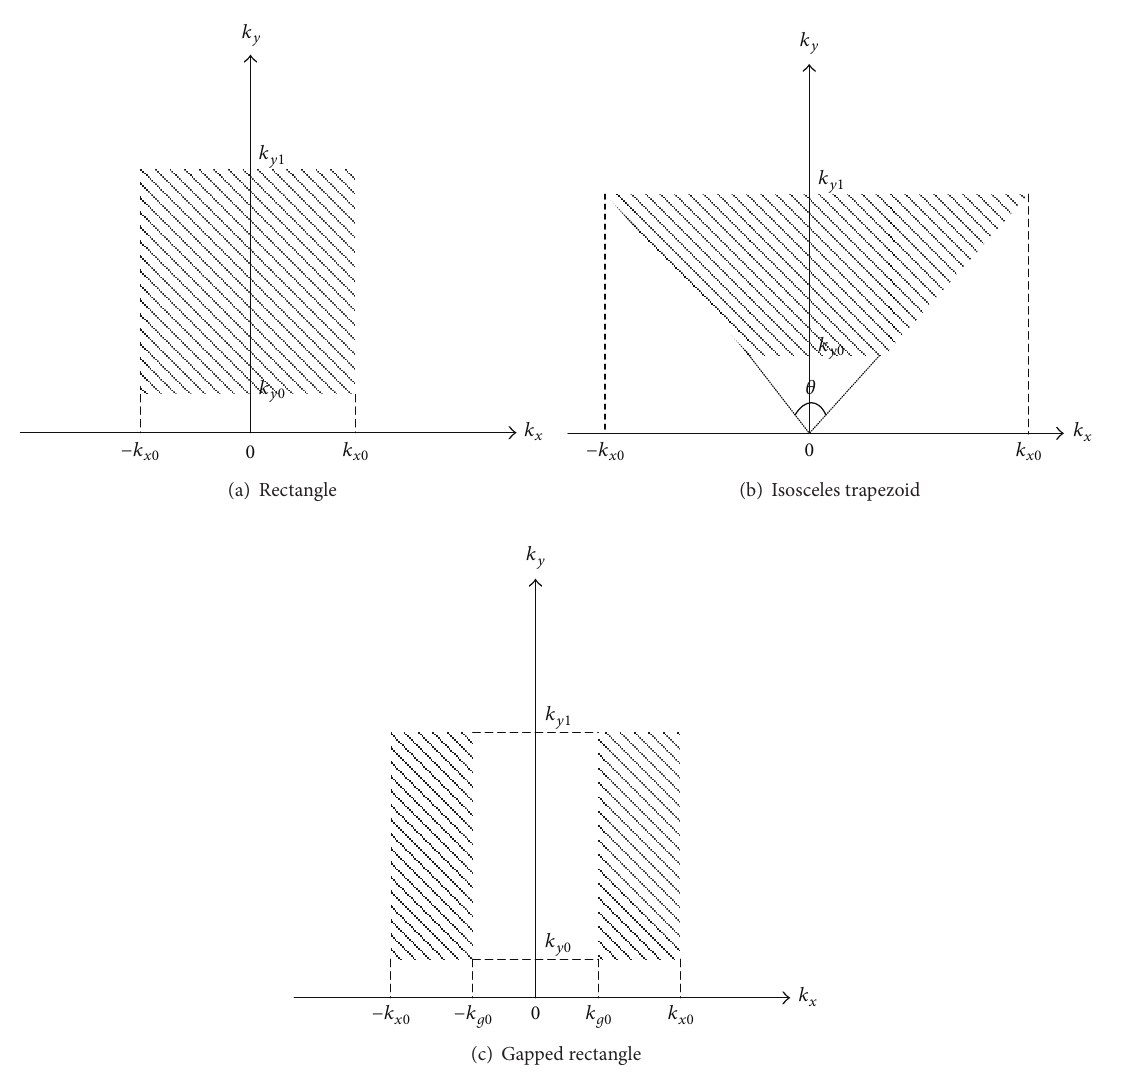
Figure 3: Geometric shapes of the spatial spectrum support